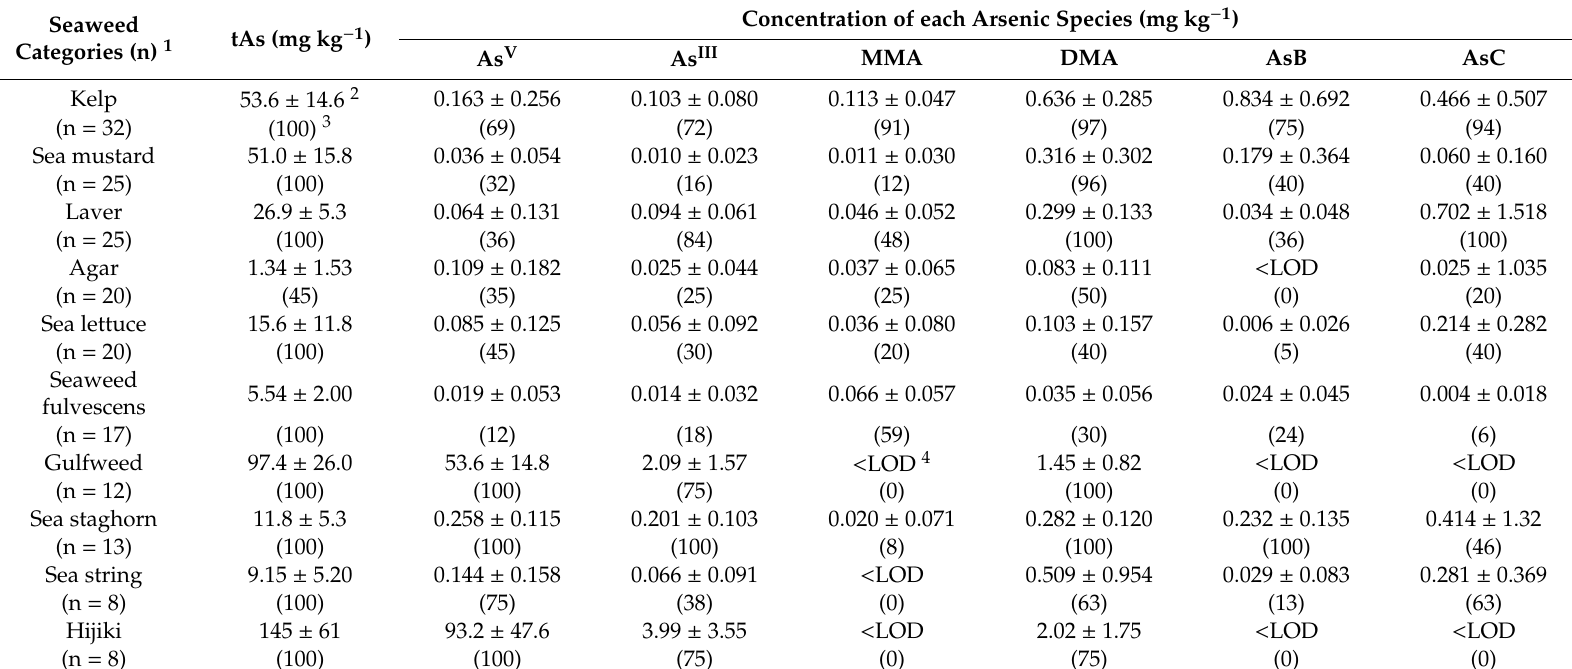
Table 2. Concentrations and detection frequency of arsenic species in